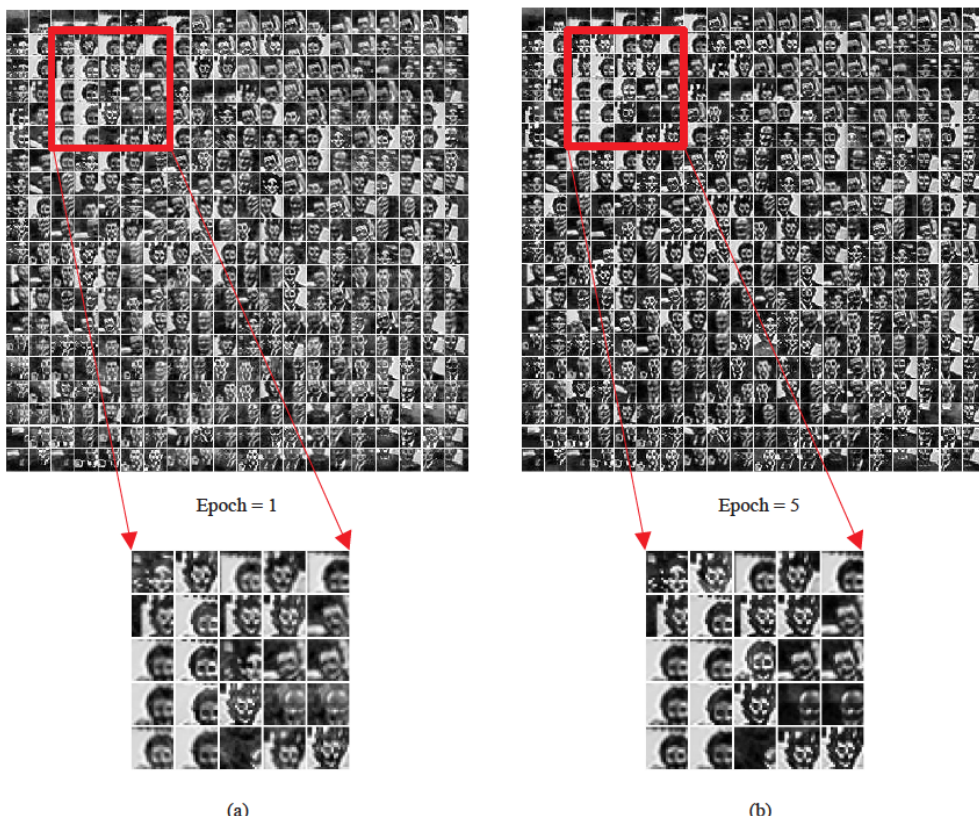
Figure 8: The first neuron regenesis case.